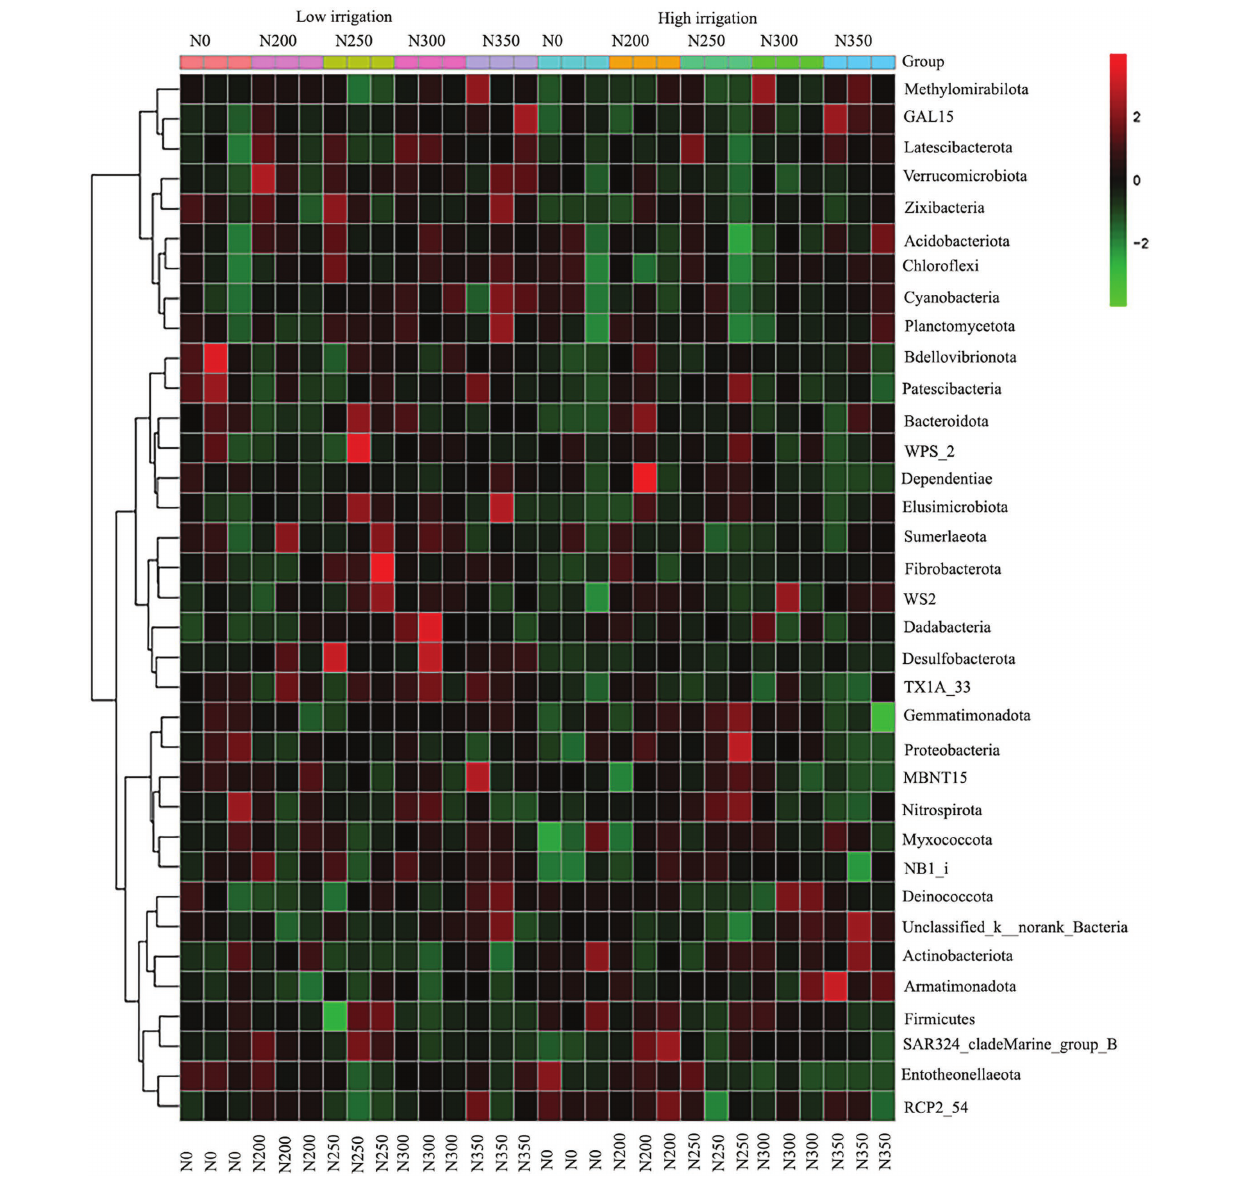
FIGURE 6 | Microbial community composition of top 50 abundant operational taxonomic units (OTUs) and their abundance level with cluster analysis. The dendrogram linkages and OTUs distances are not phylogenetic but based upon the reads number. The legend and scale represent the abundance of OTUs ( Y -axis) within each sample ( X -axis). The red indicates a more abundant phyla and green represents less abundant phyla in the corresponding